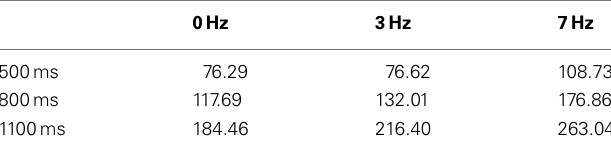
Table 1 |Average slopes of psychometric functions measured in Experiment 1.